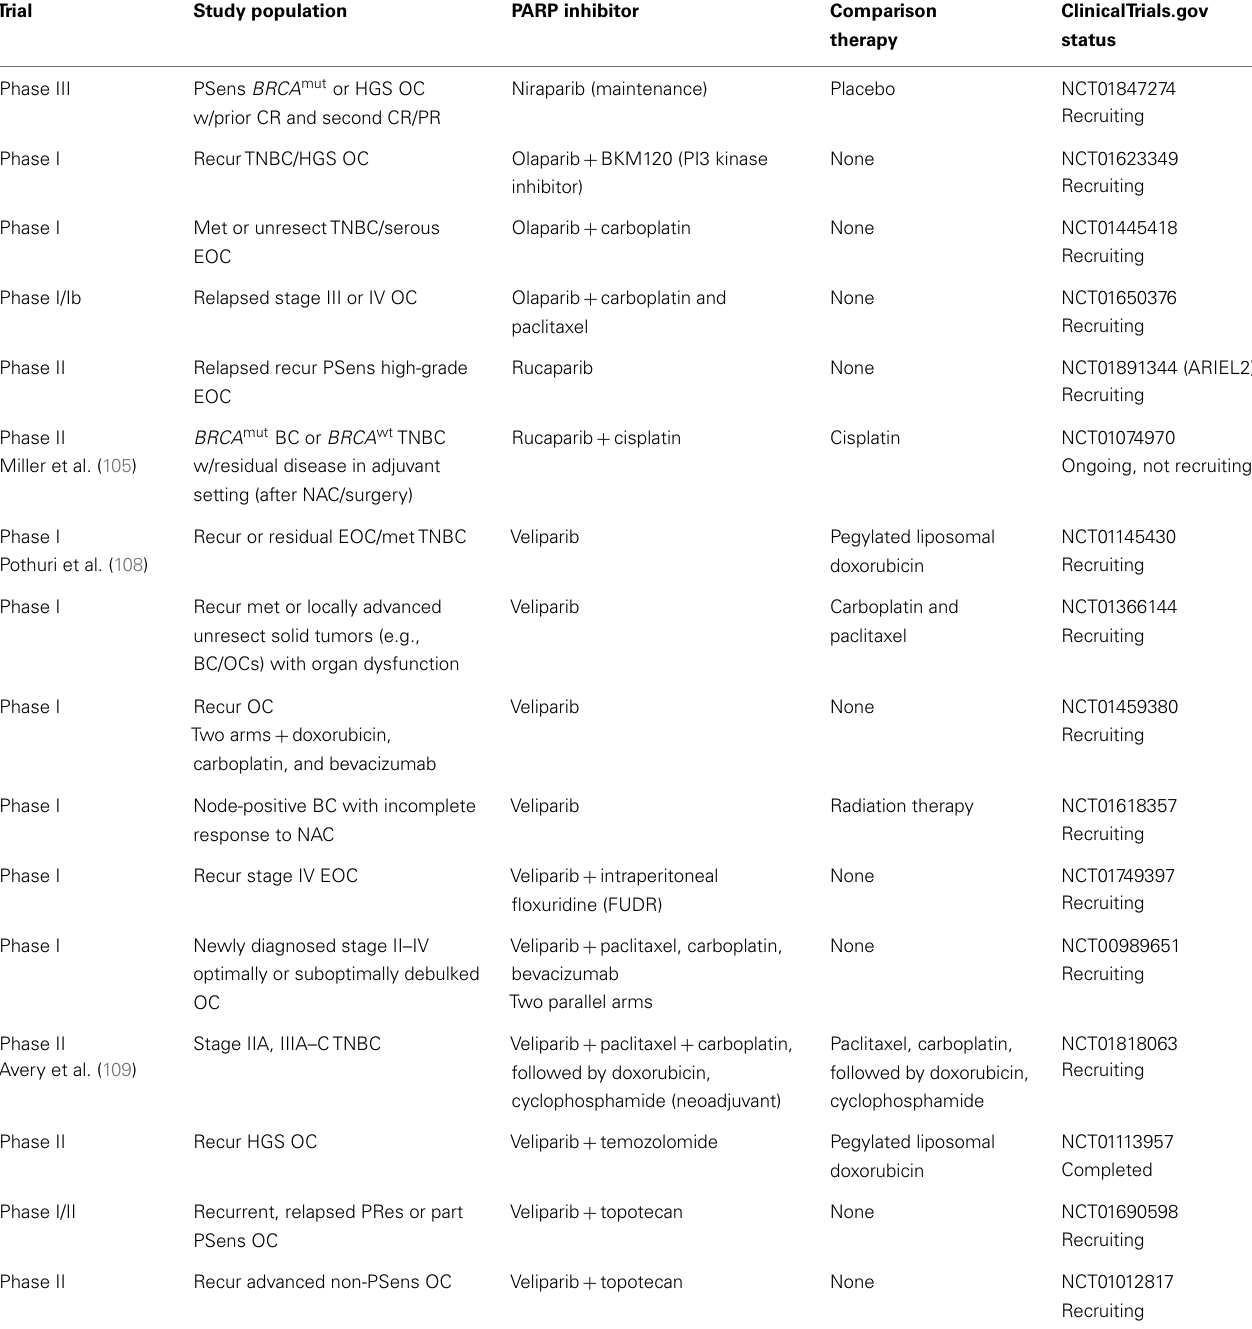
Table 6 | Ongoing or future PARP inhibitor trials in sporadic breast and ovarian